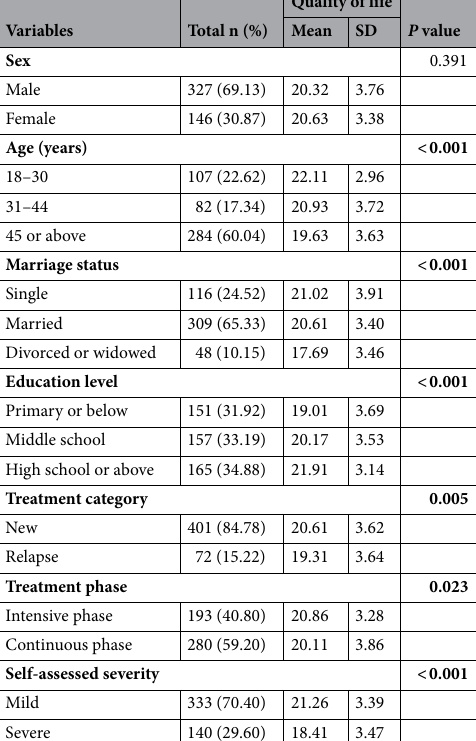
Table 1. Participants’ demographic characteristics and treatment status and their associations with QOL. SD standard deviation. Significant values are given in